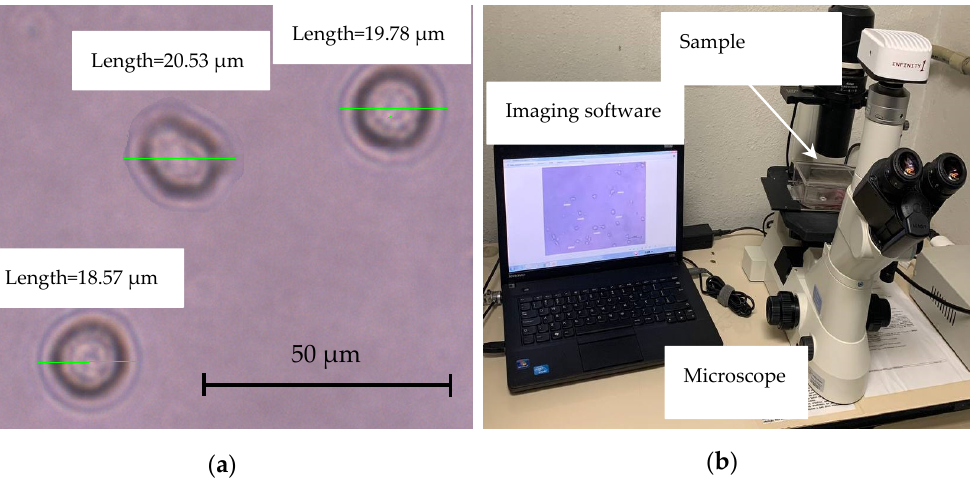
Figure 9. ( a ) Close-up of the cell size and shape measurements using optical microscope images treated by image analysis software; ( b ) Complete setup for cell size measurement.